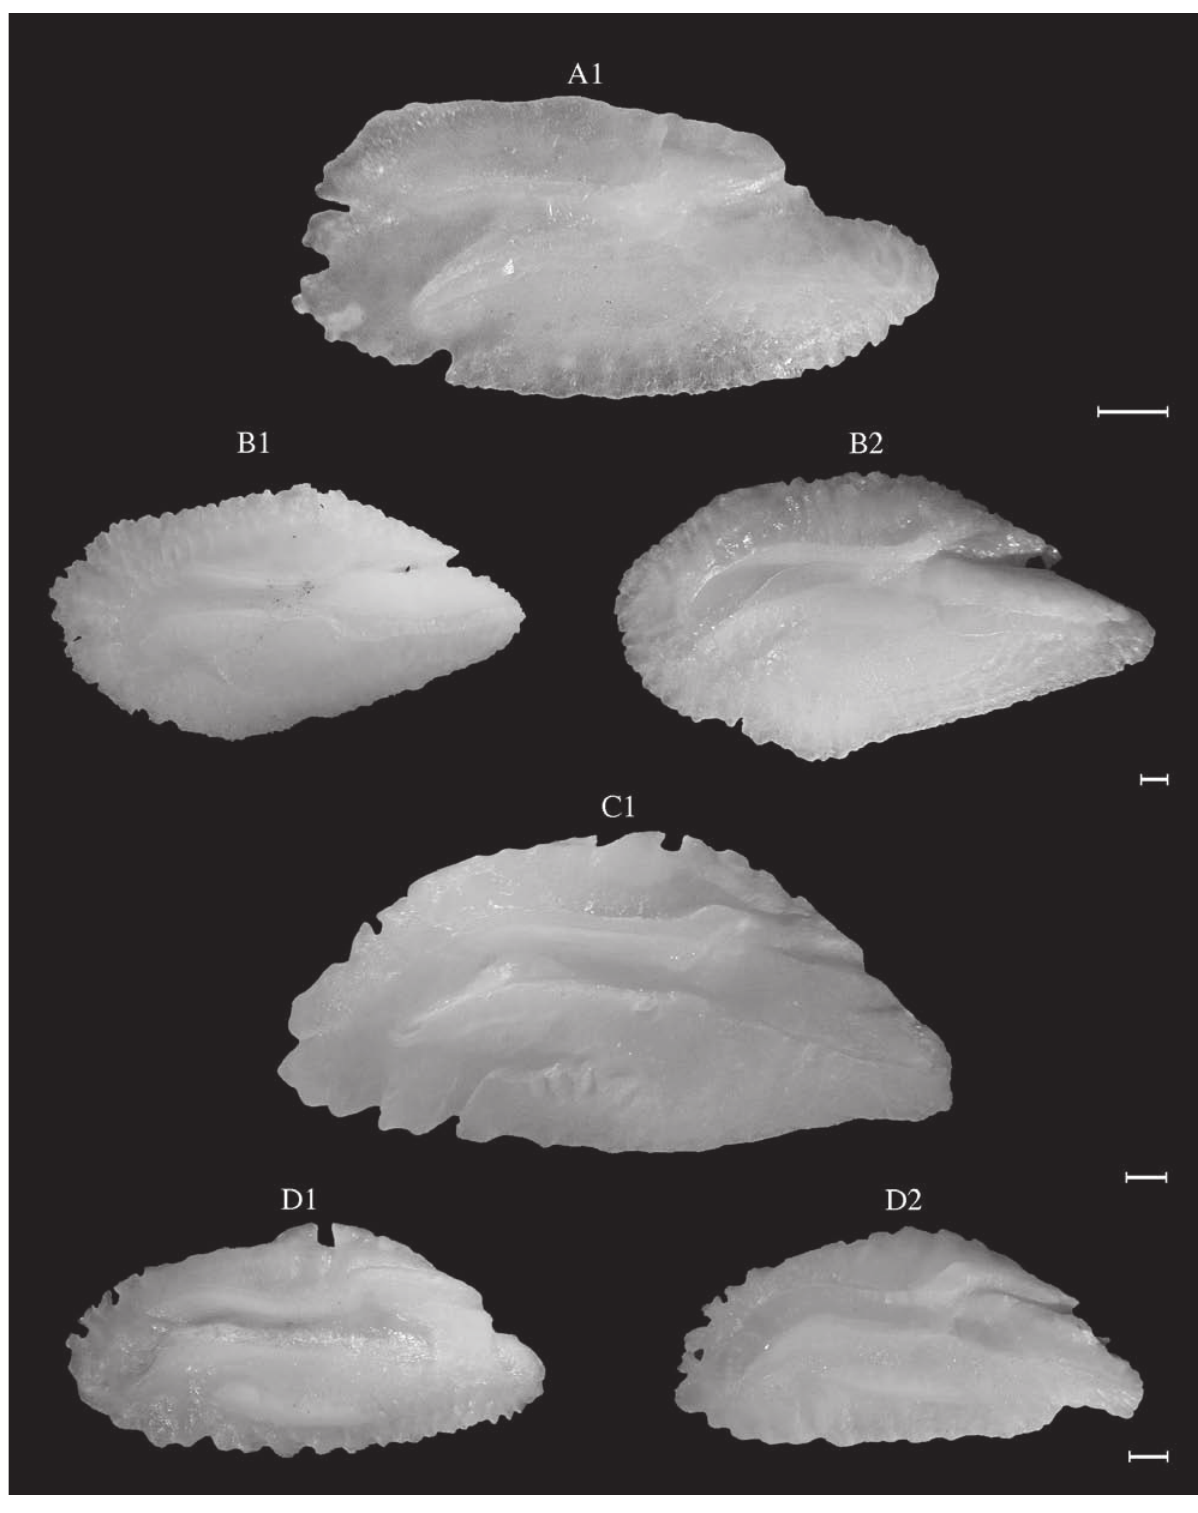
Fig. 47. – Cephalopholis taeniops (CEA). TL: A1, 19.8 cm. Epinephelus aeneus (WM). TL: B1, 48.5 cm; B2, 55.0 cm. Epinephelus caninus (CEA). TL: C1, 60.4 cm. Epinephelus costae (CEA). TL: D1, 44.0 cm; D2, 50.3 cm. Scale bar = 1